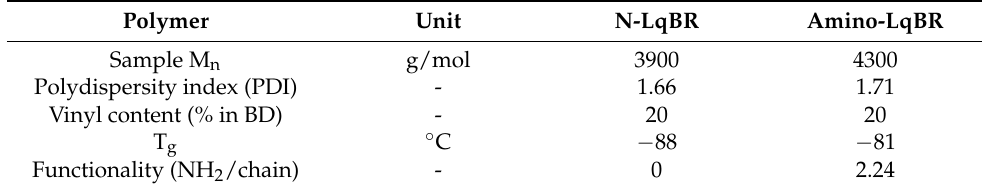
Table 4. Characteristics of